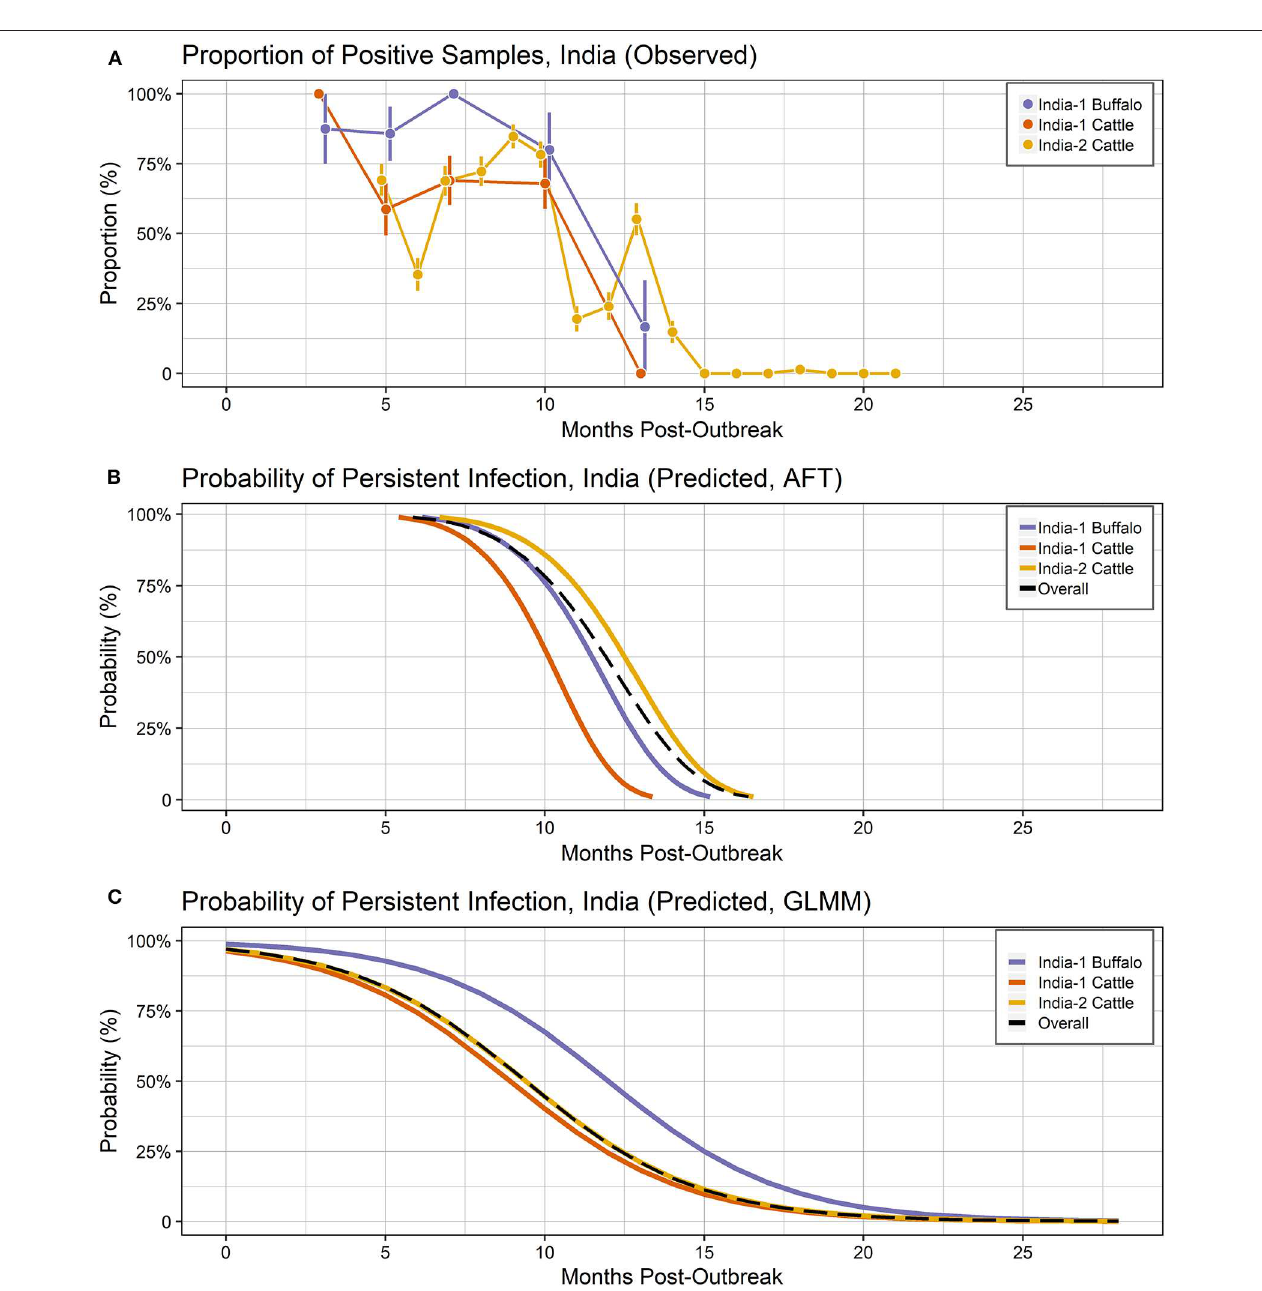
FIGURE 3 | Probability of persistent infection, India data only. All study animals were seropositive for FMDV anti-NSP antibodies by r3AB3 I-ELISA. (A) Observed proportion of OPF samples positive for FMDV RNA. Mean and standard error are shown. (B) Predicted probability of persistent infection, AFT model. (C) Predicted probability of persistent infection, GLMM